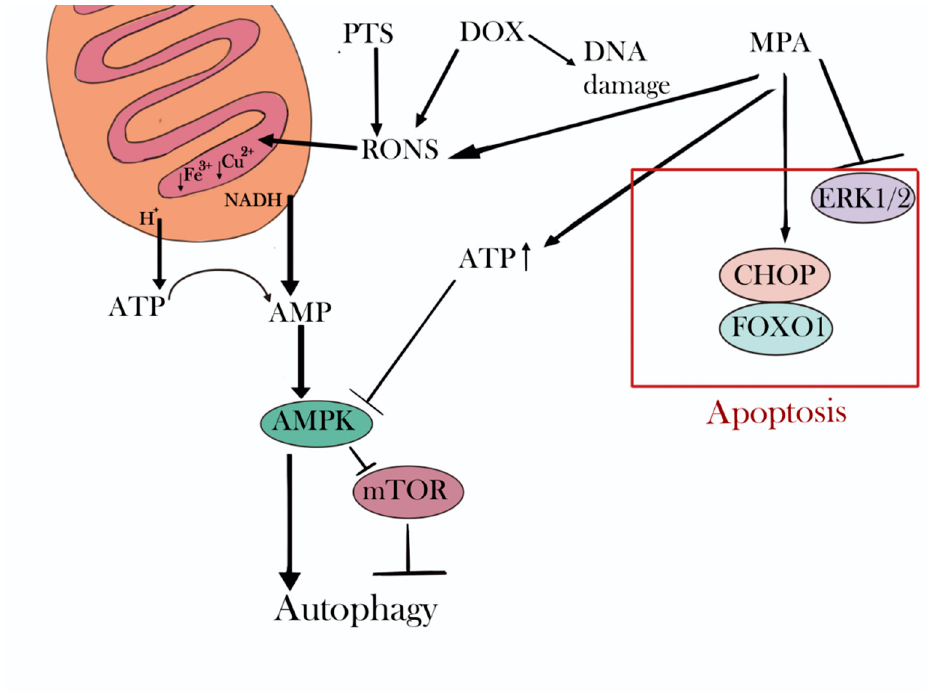
Figure 7. Breakdown of hypothetical processes in the cell caused by medroxyprogesterone acetate (MPA), doxorubicin (DOX), and a cold-plasma-treated solution (PTS). ERK1/2—the extracellular signal-regulated kinase pathways; CHOP—the C/EBP homologous protein transcription factor; FOXO1—the forkhead box protein O1; RONS—reactive oxygen and nitrogen species; mTOR—the mammalian target of rapamycin; AMPK—adenosine monophosphate activated protein kinase.